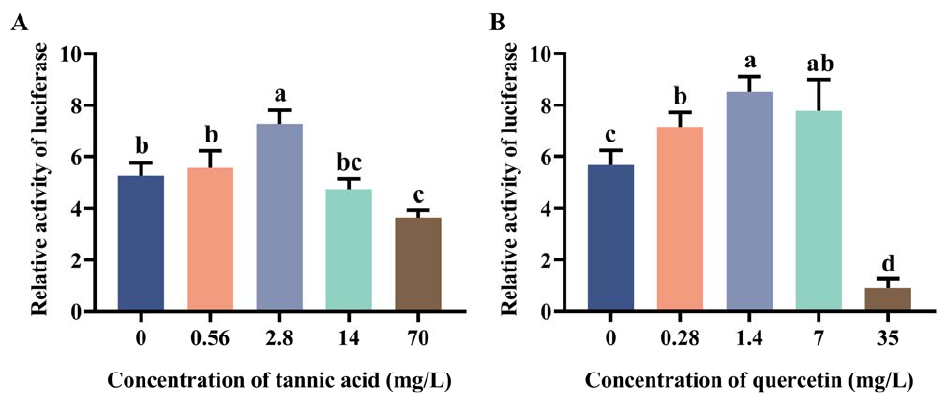
Figure 3. Promoter activity of MtGSTz1 ( − 350/+521) under tannic acid ( A ) and quercetin ( B ) stress. Each value is presented as the mean ± SD of three replicates, and different lowercase letters show significant differences ( p < 0.05).